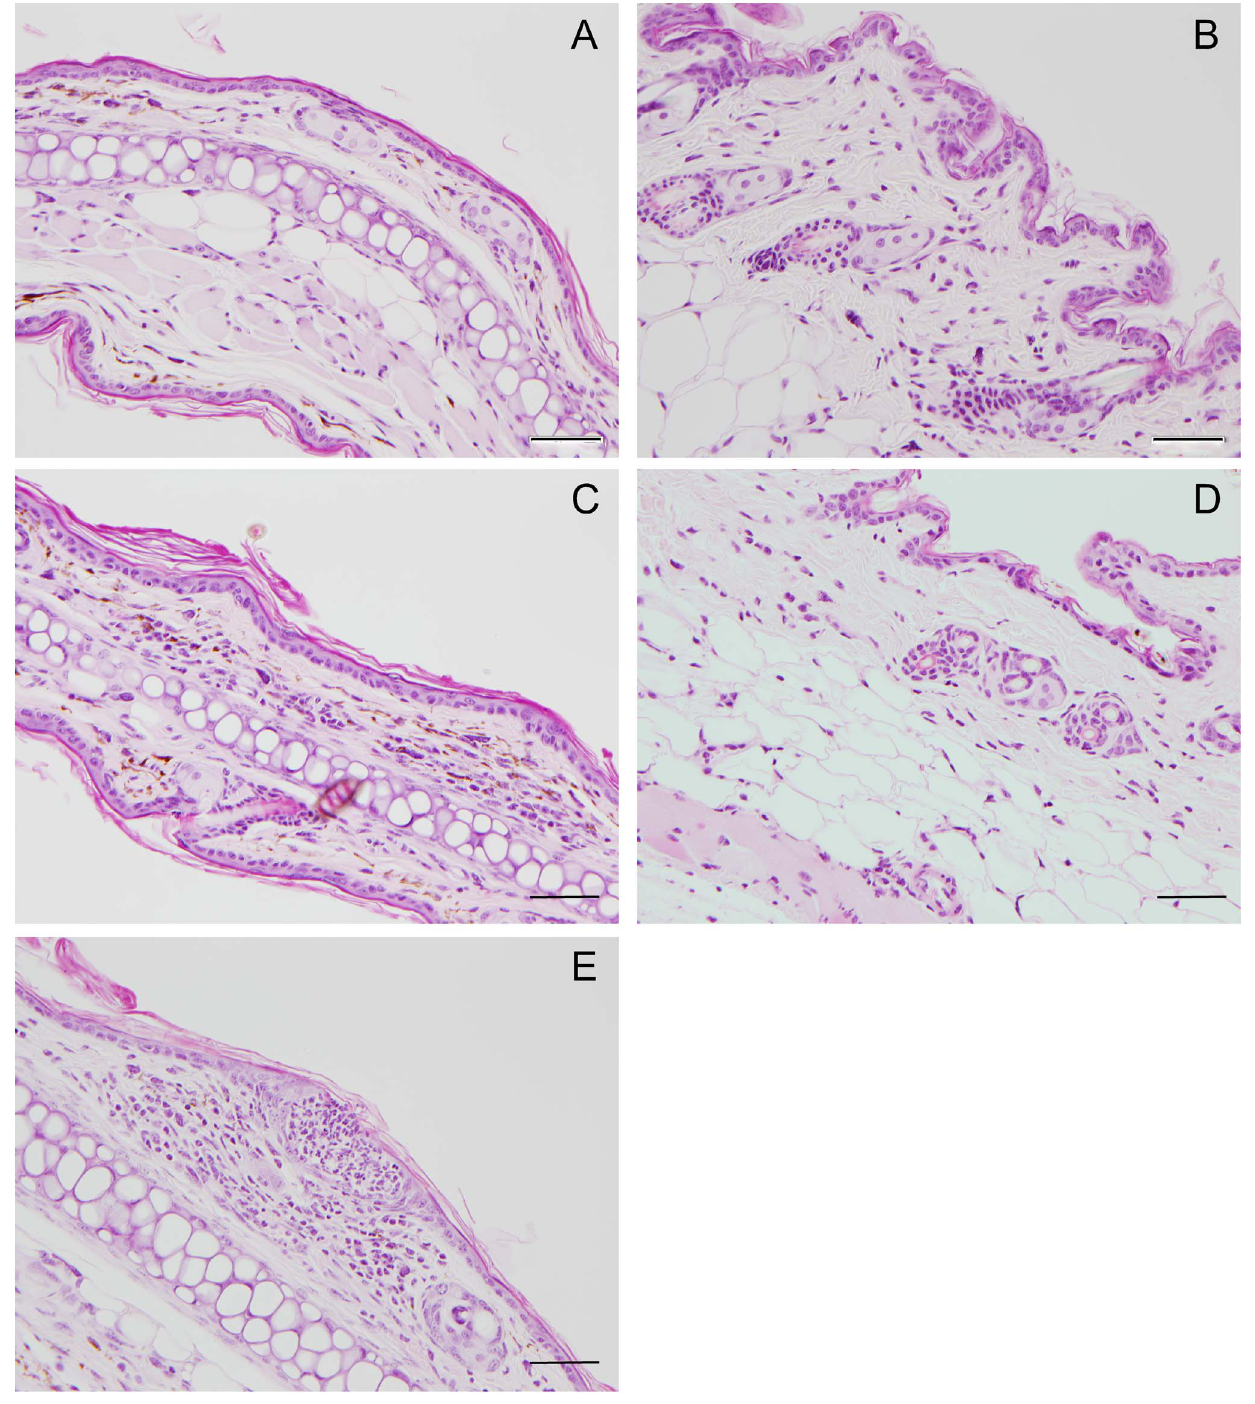
Figure 1. Minor histological changes in skin of naive mice within 48 h of exposure to flea bites. Representative skin sections from ear ( A , C ) and abdomen ( B , D ) collected from mice 24–48 h after flea bites ( C, D ) or from normal unbitten control mice ( A, B ). Flea feeding induced minimal inflammation (score=1) compared to control ear (score=0). Panel E shows a focus of neutrophil infiltration found in one mouse 24 h after flea feeding (score=2). Ten of 15 mice were indistinguishable from the unfed controls. See Methods for scoring criteria. Scale bars=50 m m. group there was a significant positive correlation between those in PBS controls until 24 h pi, even in mice with 4–5 log 10 log 10 CFU and % Ly-6G + cells (P= 0.007), but with a low r 2 bacteria (Fig. 2E and F), with or without flea feeding. In the Y. (0.354). The correlation was dependent on the three mice at 24 h pesti s-only group, there was no correlation between log 10 CFU and % Ly-6G + cells (r =0.08, P =0.70). In the fleas + Y. pestis pi with an influx of neutrophils well above those seen in PBS